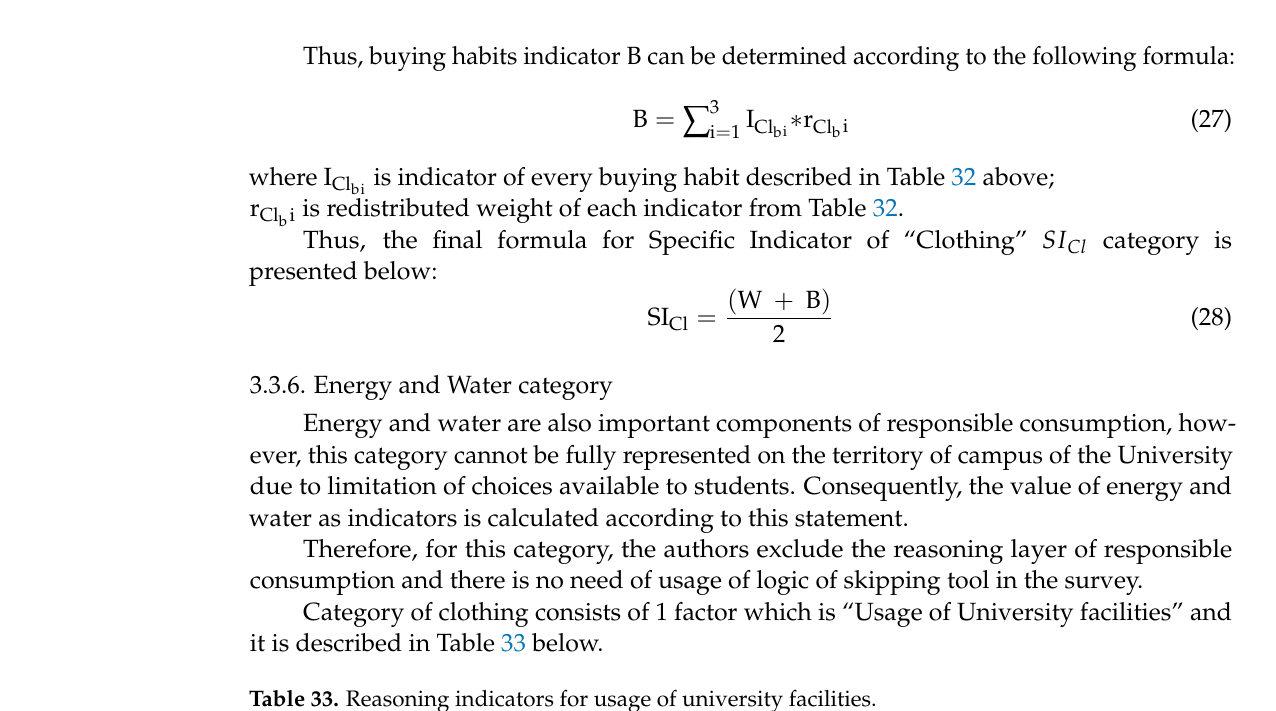
Table 33. Reasoning indicators for usage of university